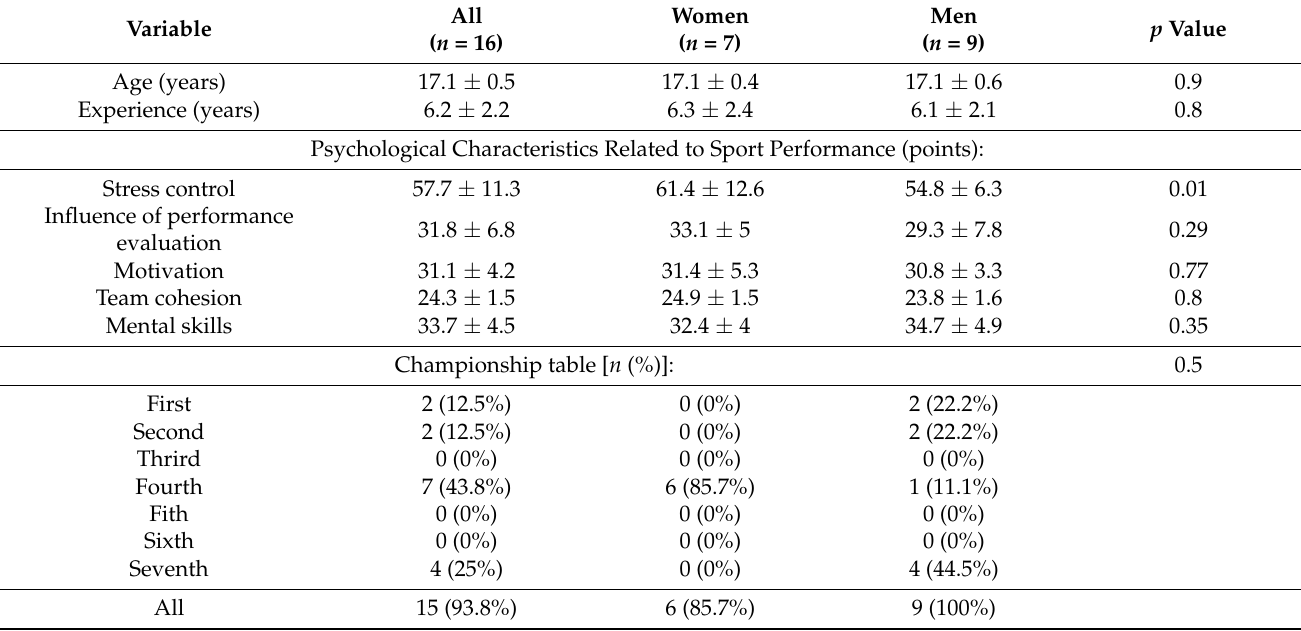
Table 1. Characteristics of the participants at baseline.